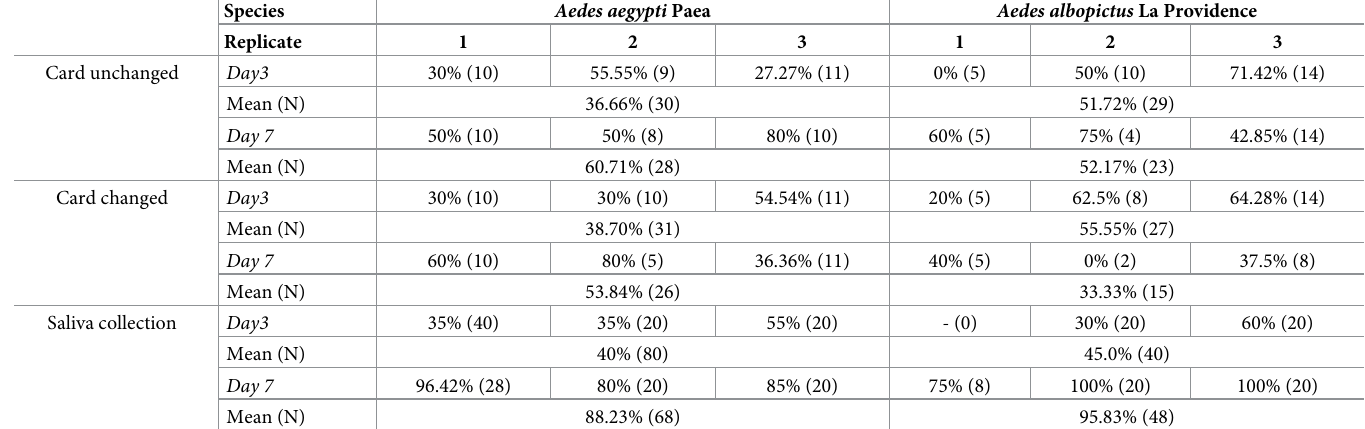
Table 1. Transmission efficiencies (%) of Aedes aegypti Paea and Aedes albopictus La Providence, 3 and 7 days after exposure to an infectious blood meal containing 10 6.5 pfu/mL of CHIKV. Saliva were collected using the forced salivation technique and quantified by RT-qPCR. In brackets, number of mosquitoes